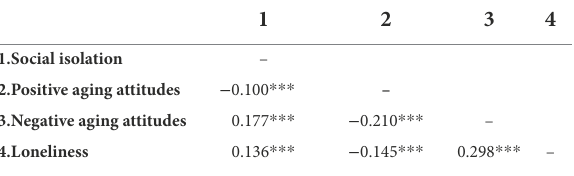
TABLE 4 A hierarchical regression analysis for moderating effects in the relationship between social isolation and loneliness.